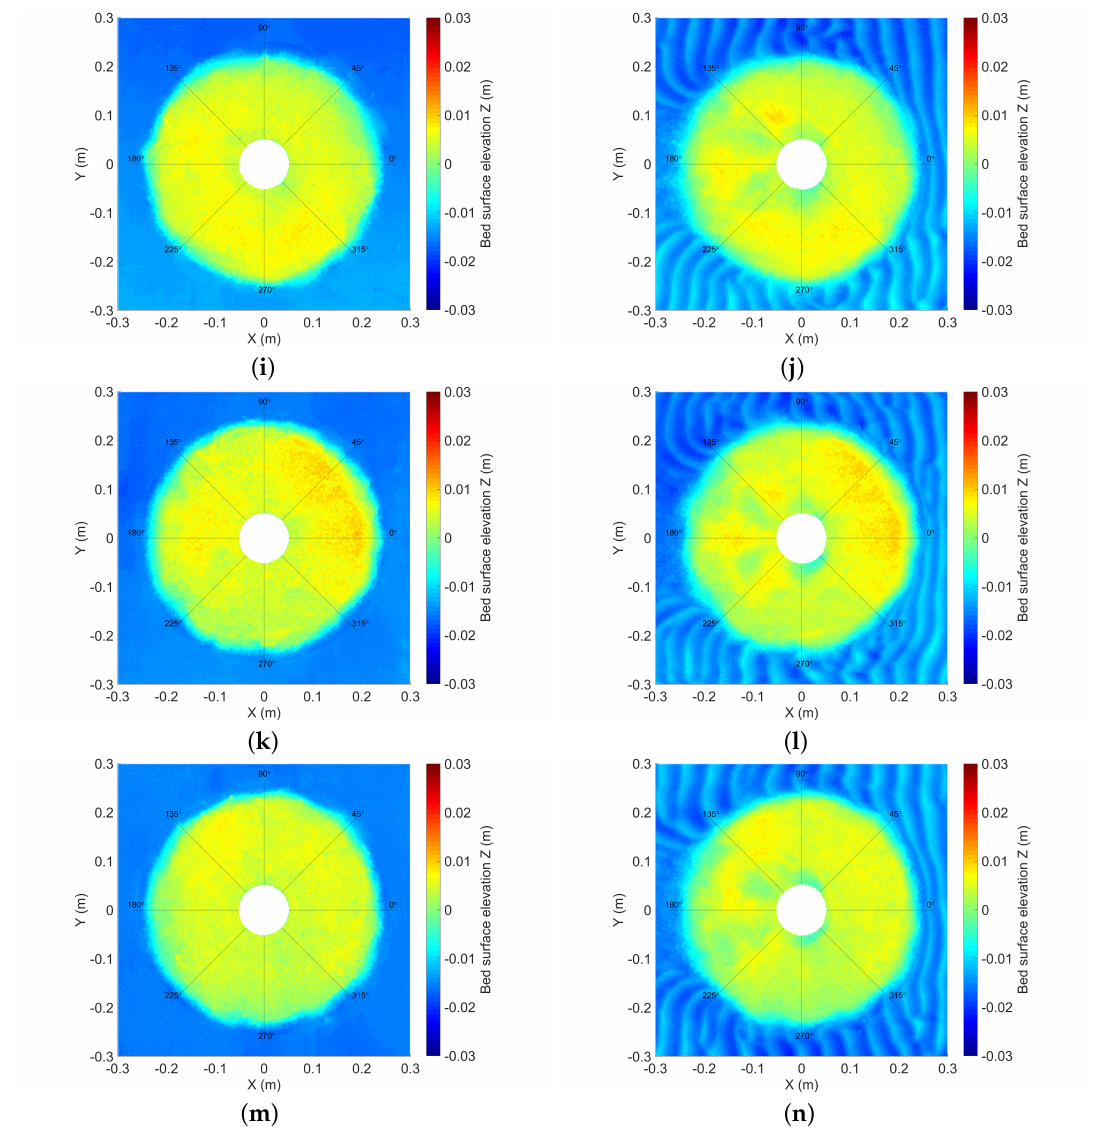
Figure 12. Initial and end profiles of TG2: ( a ) TG2_1 initial profile; ( b ) TG2_1 end profile; ( c ) TG2_2 initial profile; ( d ) TG2_2 end profile; ( e ) TG2_3 initial profile; ( f ) TG2_3 end profile; ( g ) TG2_4 initial profile; ( h ) TG2_4 end profile; ( i ) TG2_5 initial profile; ( j ) TG2_5 end profile; ( k ) TG2_6 initial profile; ( l ) TG2_6 end profile; ( m ) TG2_7 initial profile; ( n ) TG2_7 end profile. The Cartesian system presented in Figure 9 is